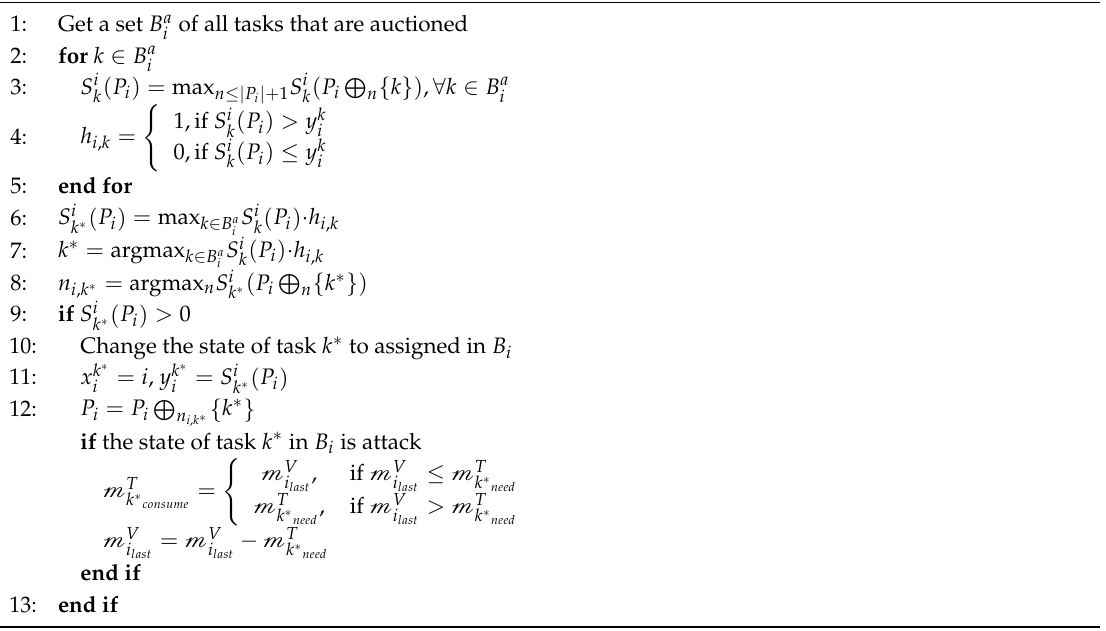
Algorithm 2. Task